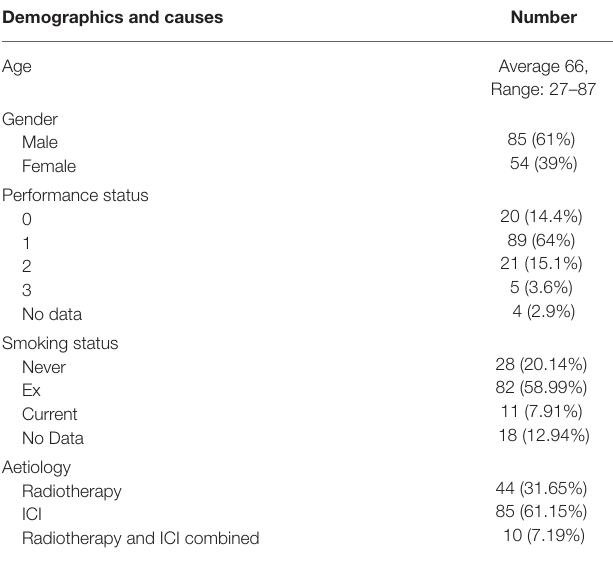
TABLE 1 | Symptomatic (grade ≥ 2) pneumonitis demographics and aetiology. Demographics and